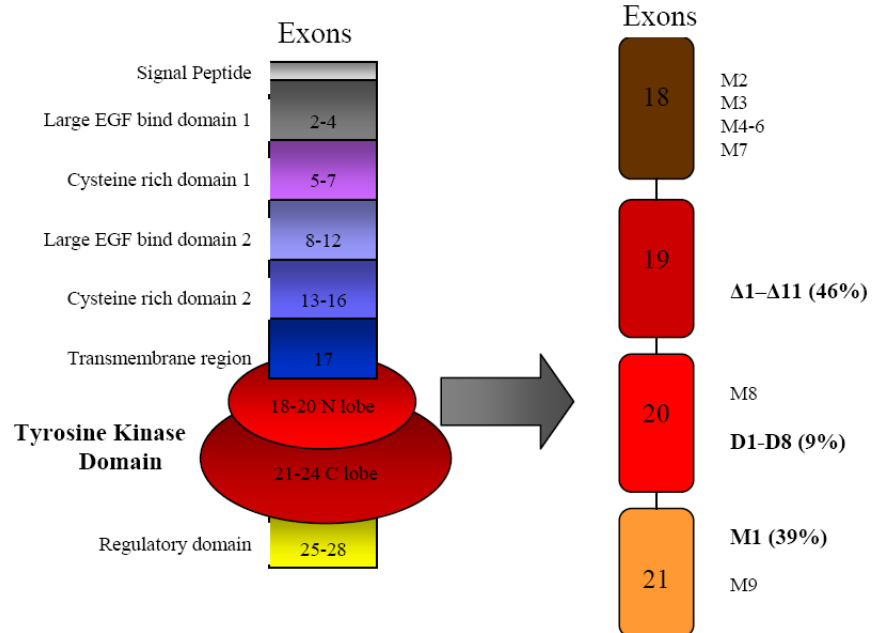
Figure 2. Modular structure of EGFR gene and mutations. The structure of the EGFR gene is shown on the left, and the locations and types of the mutations in the tyrosine kinase (TK) domain are shown on the right. All mutations were located within exons 18–21, which encode the N lobe and part of the C lobe of EGFR (red area of the gene on the left, which is presented in magnified form on the right). Three major types of mutations (shown in bold ) formed 94% of the 134 mutations detected and consisted of deletions in exon 19 (labeled Δ1–Δ11), duplications and/or insertions in exon 20 (eight types labeled D1–D8), and a single-point mutation, L858R (labeled M1). The remaining 6% of mutations consisted of missense mutations in the P-loop in exon 18 (six types labeled M2–M7), exon 20 (a single type labeled M8), or exon 21 (a single type labeled M9). (Adapted from Shigematsu et al .